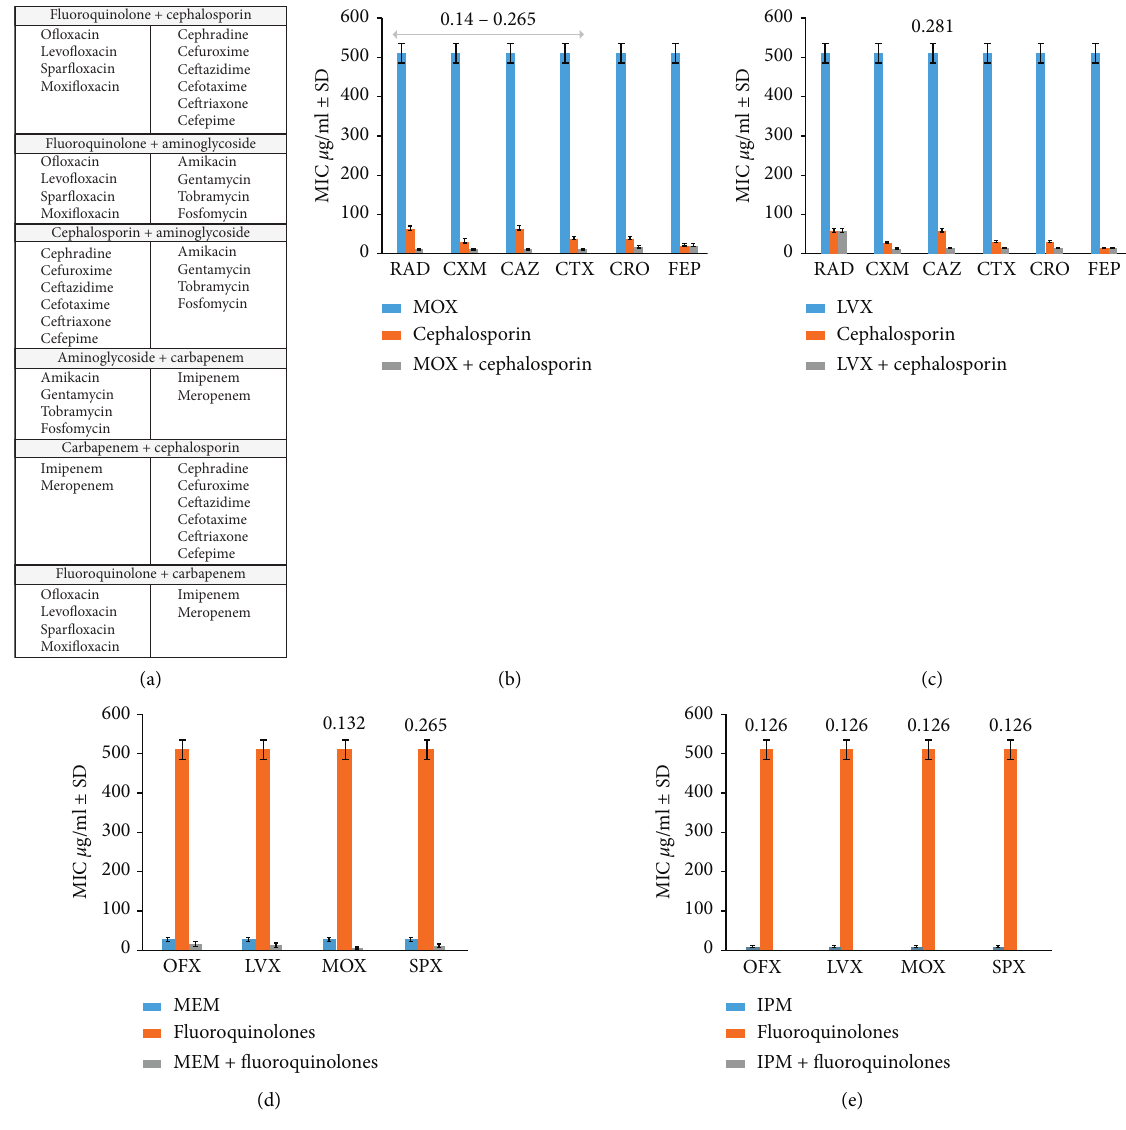
Figure 3: Time-Kill kinetics on antibiotics individually and collaterally. (a) Levofloxacin-ceftazidime combination with 8-fold growth reduction compared to most active monotherapy. (b) < 2-log 10 difference in killing with amoxicillin-clavulanic acid-cephradine com- bination therapy compared to most active single treatment shows lack of synergy. (c) Amoxicillin-clavulanic acid-ofloxacin combination is collaterally indifferent as decrease in bacterial growth is < 2-log 10. (d) Amoxicillin-clavulanic acid-tobramycin combination shows synergy because of > 2-log 10 growth reduction. (e) Collateral sensitivity is shown in piperacillin-tazobactam-tobramycin combination.